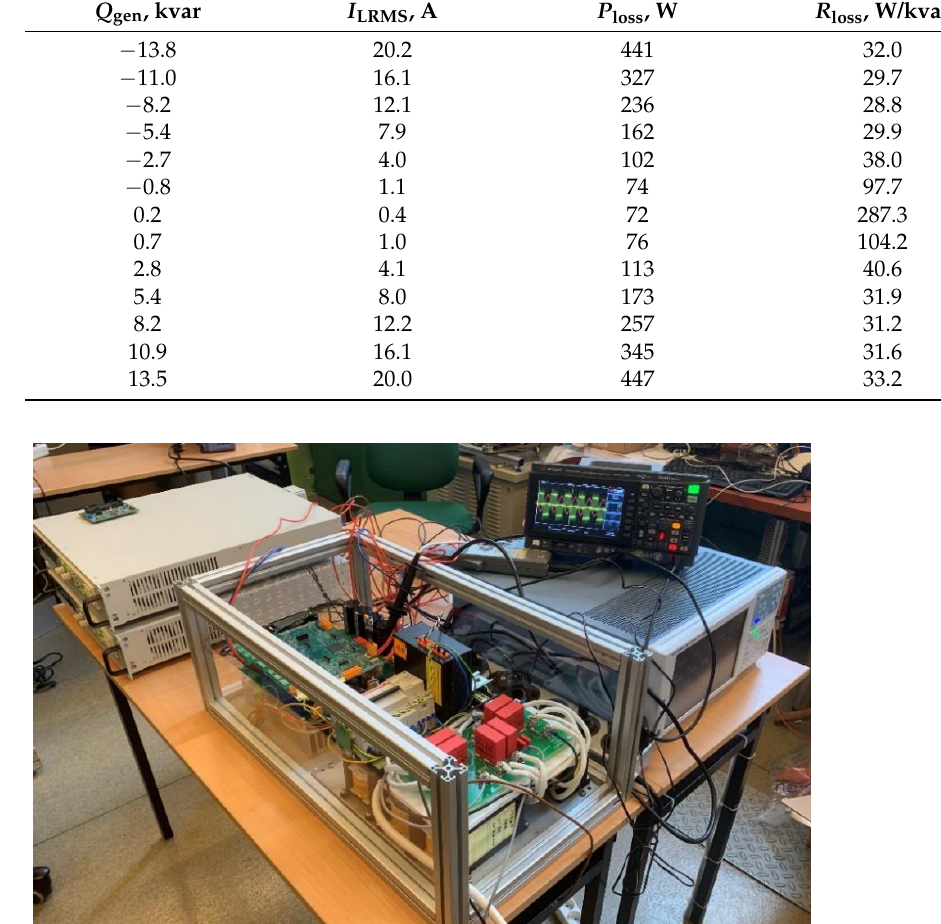
Table 2. Results of power losses measurement of APF operating in reactive power generation mode.